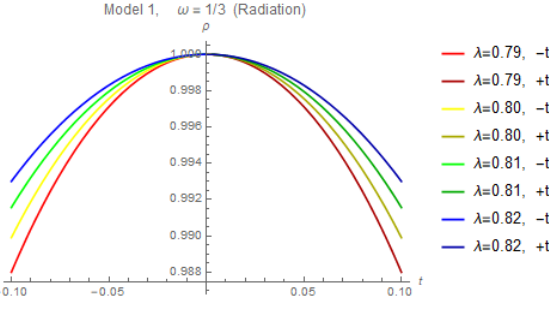
Figure 1: Plot of ρ against time.